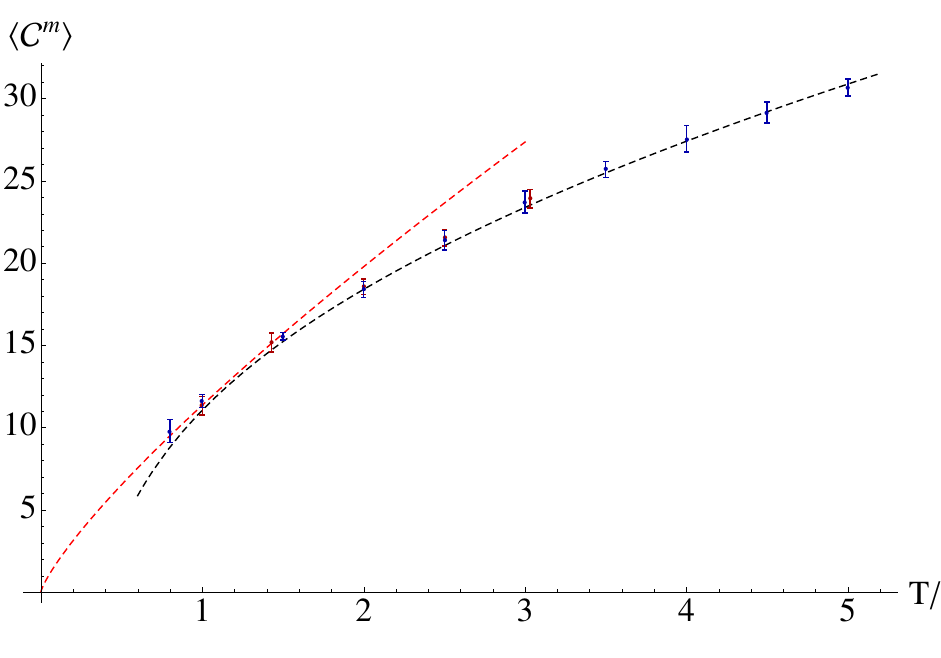
Figure 1 . The red curve represents the holographic prediction (3.8), while the black dashed curve corresponds to the high temperature expansion curve (4.2). The blue bars represent the results of lattice simulations using the lattice discretisation in ref. [15]. The red bars correspond to independent lattice simulations based on a di(cid:11)erent lattice discretisation.